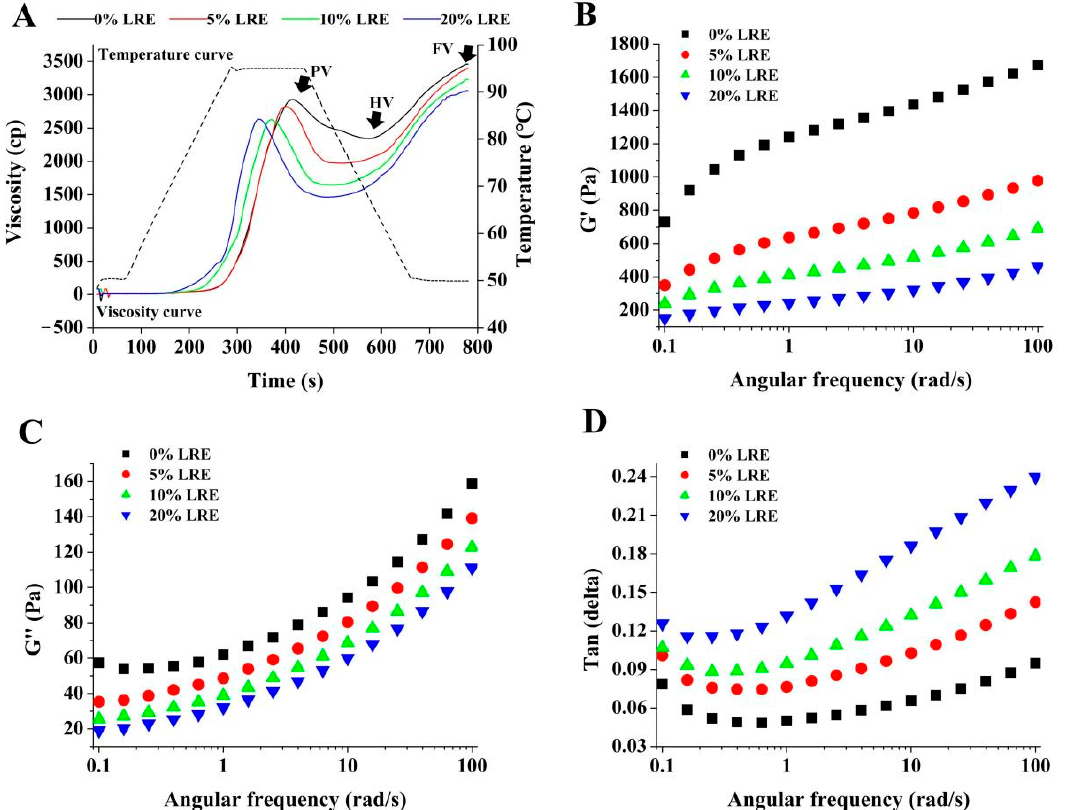
Figure 1. Effect of LRE on the pasting and rheological properties of wheat starch. ( A ) Pasting property, ( B ) storage modulus (G ′ ), ( C ) loss modulus (G ″ ), ( D ) loss tangent (Tan δ ). LRE: Ligustrum robustum (Rxob.) Blume extract.